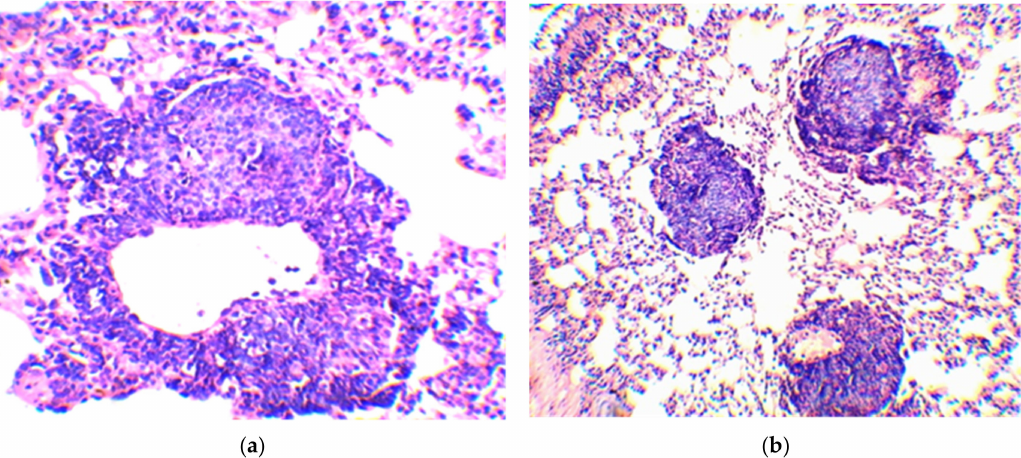
Figure 3. Guinea pig lung from group one. ( a ) Two lymphatic follicles with reactive centers forming near the wall of the vessel (magnification of 100 × ). ( b ) Lymphatic follicles with a pronounced reproduction center. A connection with a blood vessel is observed in the lower follicle (magnification of 5 × ). Table 3. Morphometric parameters of BALT lymphatic follicles in guinea pigs infected with M. bovis .